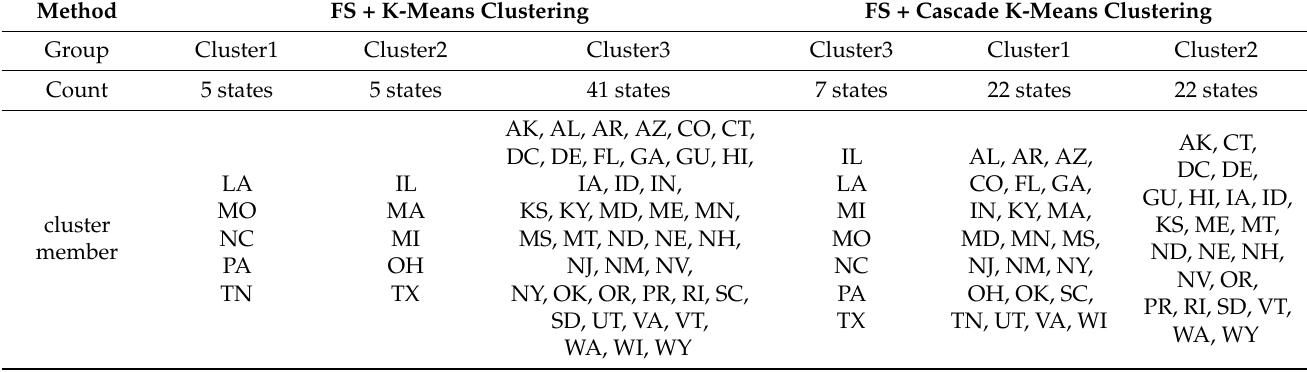
Table 7. Clustering results.